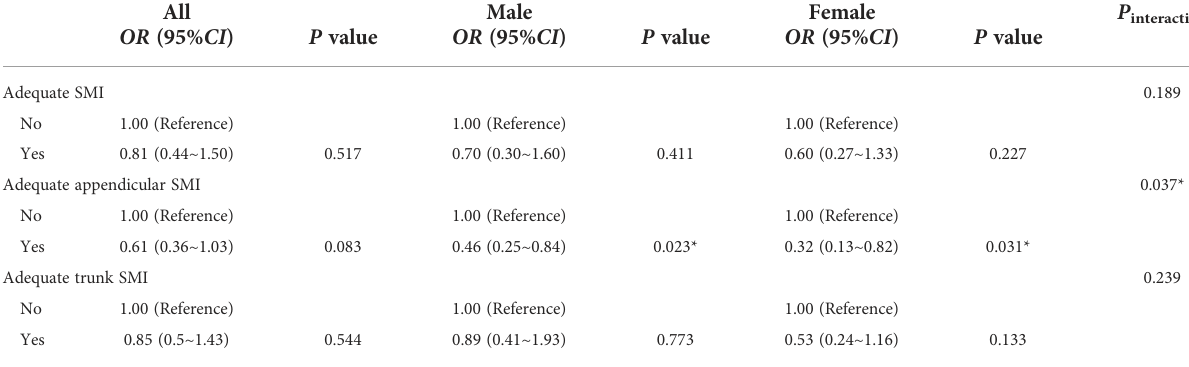
TABLE 2 Associations between adequate muscle mass status and MAFLD by sexes.